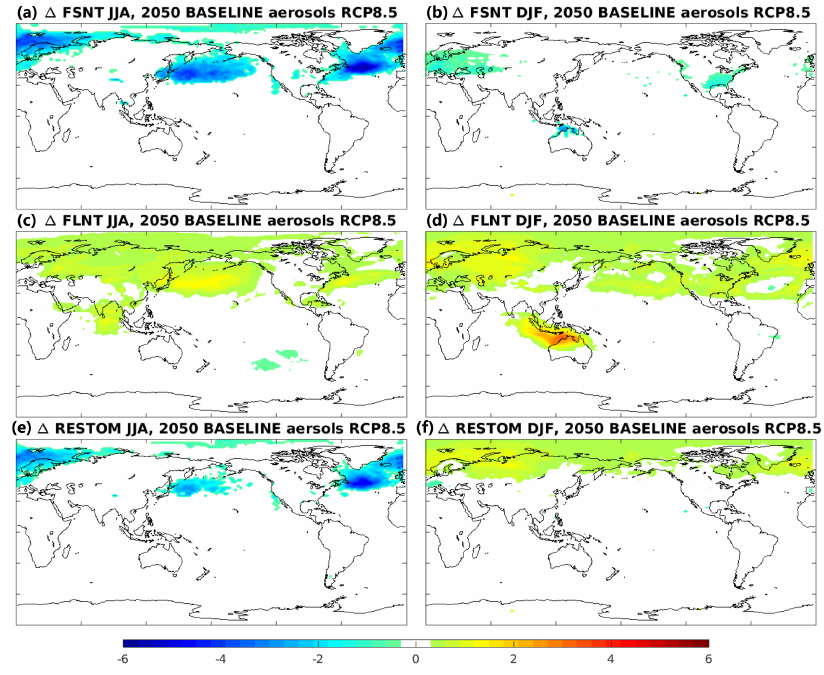
Figure 10. Ensemble mean of seasonally averaged shortwave (FSNT: a, b ), longwave (FLNT: c, d ) and net (RESTOM: e, f ) radiative forcing in mWm 2 at the top of the atmosphere due to 2050 baseline aviation aerosols with RCP8.5 2050 meteorology. Only perturbations above 2 standard deviations of the corresponding control simulation are considered in the ensemble